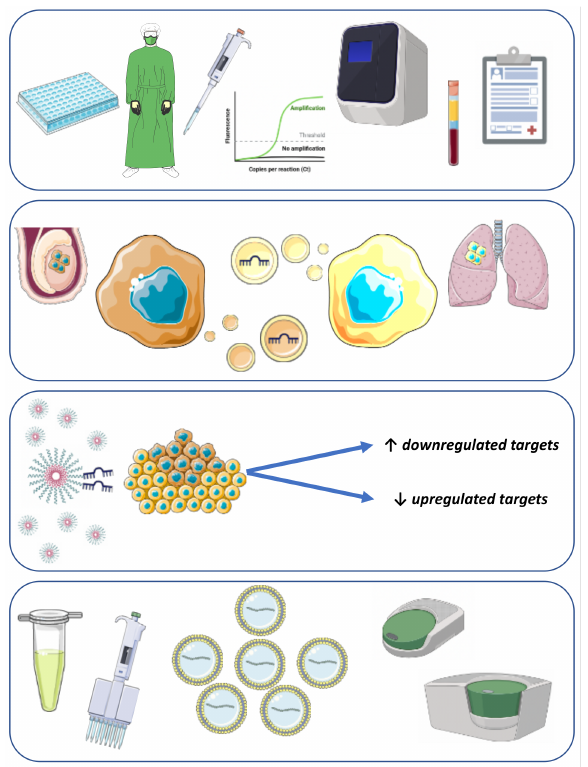
Figure 2. Possible future directions in liquid biopsy testing in TGCTs, including standardization of protocols and reports, studies in exosomes, biomolecule delivery through nanoparticles, and improved techniques such as droplet digital